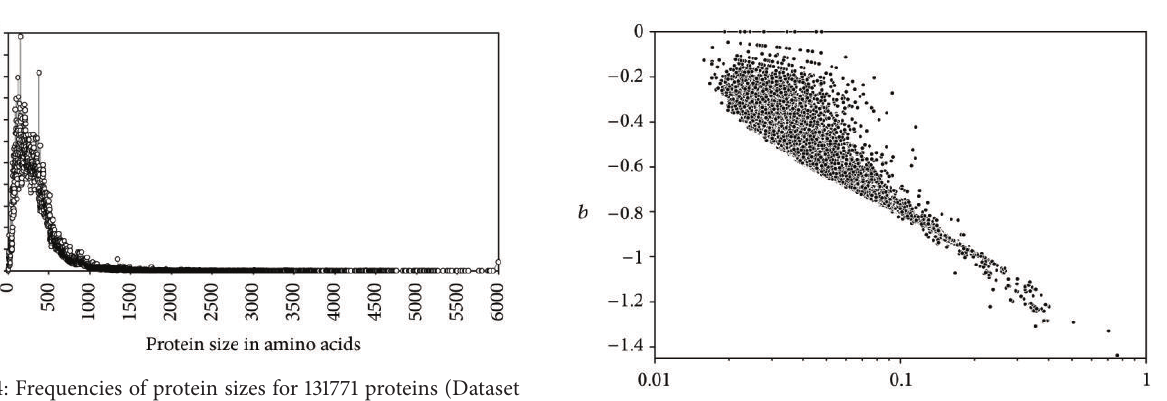
Figure 4: Frequencies of protein sizes for 131771 proteins (Dataset 1).